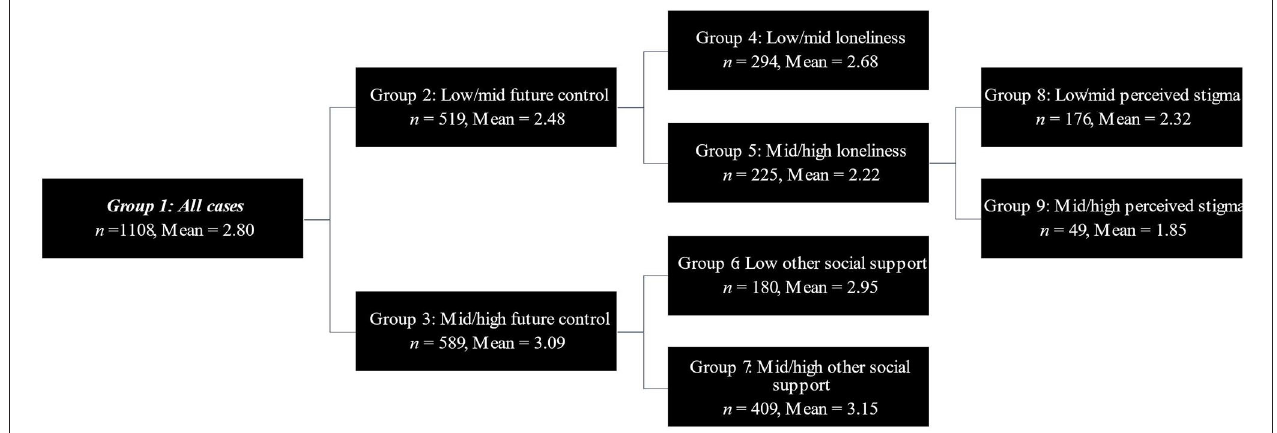
FIGURE 2 | SEARCH-ing for future orientation. The decision tree for the outcome future